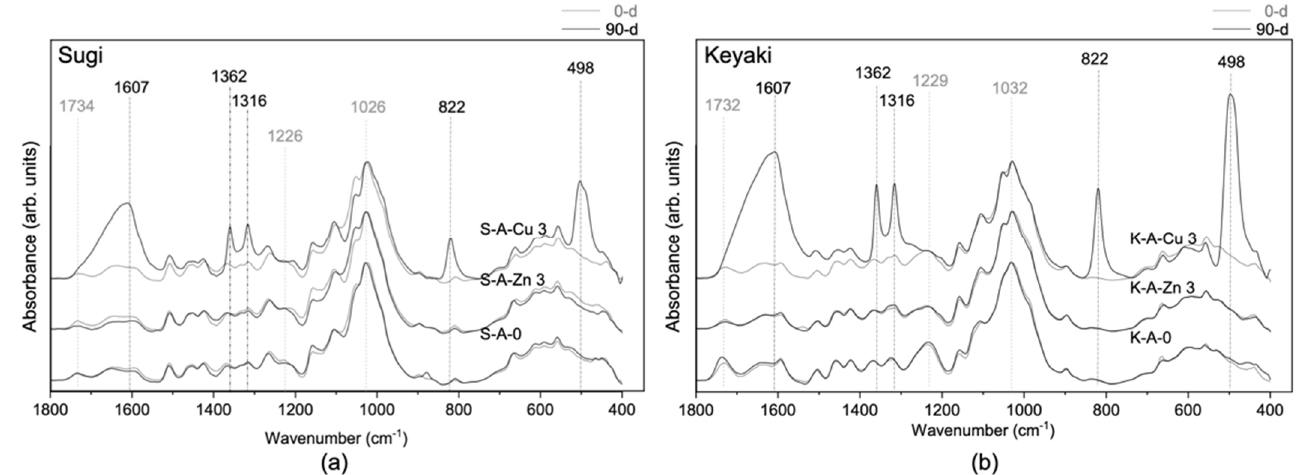
Figure 5. FTIR spectra for ( a ) S-A-Cu 3/Zn 3/0 and ( b ) K-A-Cu 3/Zn 3/0 after 0/90-day exposures. The average changes and standard deviations in the absorbance at 822 cm − 1 with the unexposed samples are presented as a percentage in Figure 6. The increase in the absorb- ance at 822 cm − 1 with the exposure day could be observed in most of the Sugi and Keyaki samples with Cu(II) contents, and the more Cu(II) the samples contained, the more signif- icant the increase. The K-A-Cu 3 showed the most rapid increase ultimately as a dramatic higher average change after a 90 d exposure (40,432.5%). The samples with Zn(II) ap- peared less pronounced. For instance, the Sugi groups and most Keyaki groups showed few differences with the blank samples, regardless of the Zn(II) content level. The increase could only be observed in the case of K-A-Zn 3. Table 2. Wood cell wall structural constituents, metal oxalate and assignment of FTIR characteristic bands .